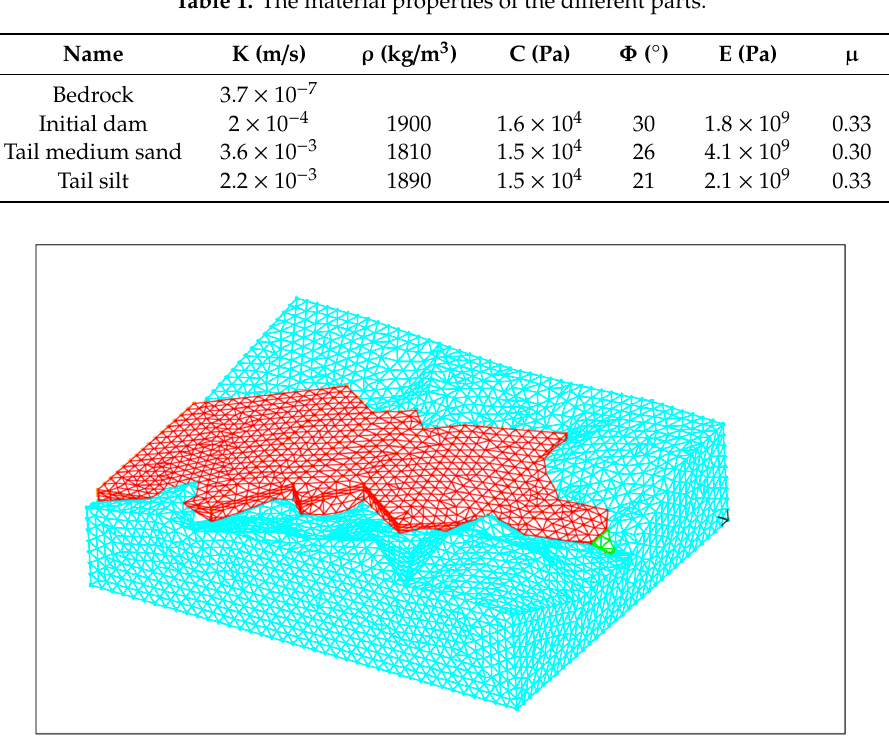
Table 1. The material properties of the different parts.